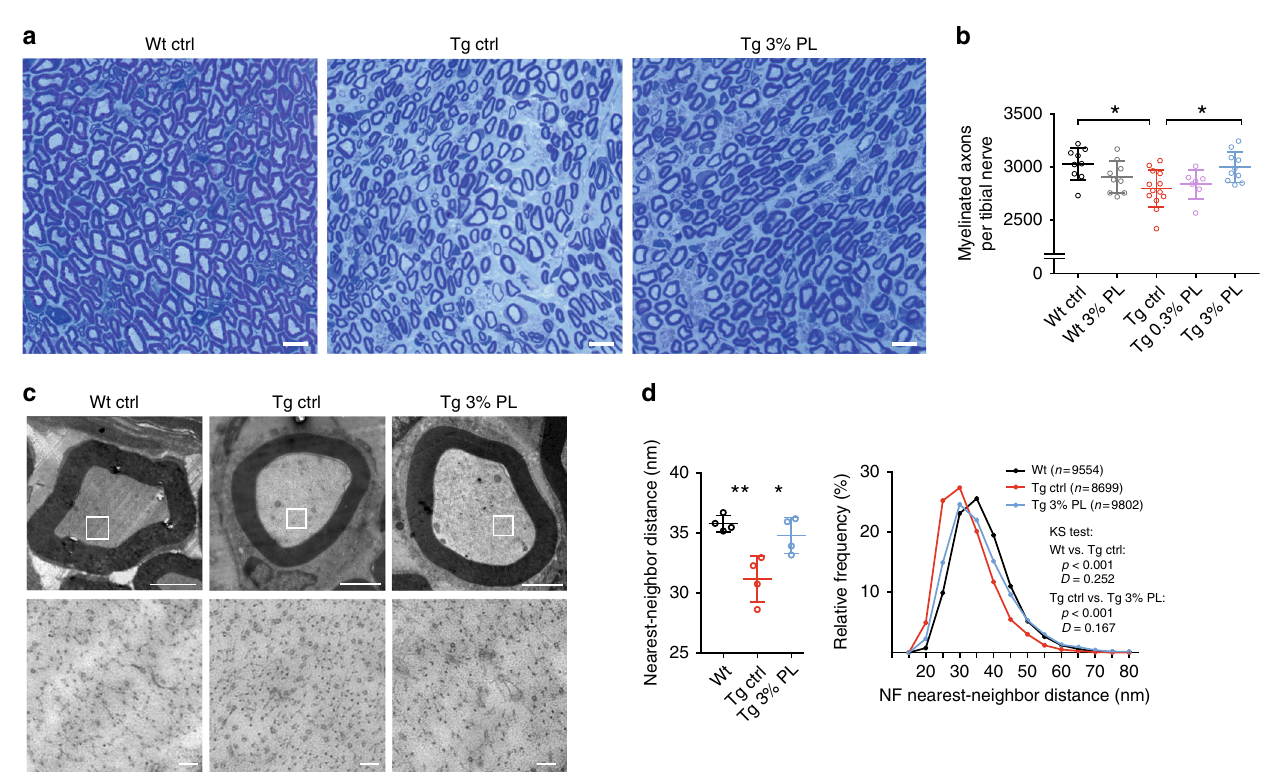
Fig. 3 Phospholipid therapy in CMT rats improves myelination. a Methylene blue semi-thin sections from tibial nerve cross sections at P112 from Wt ctrl (left), Tg ctrl (middle), and Tg 3% PL (right). Note the reduced density of myelinated fi beres in Tg ctrl compared with Wt ctrl, which is improved in Tg 3% PL (scale = 10 µ m). b Light microscopic quanti fi cation of a displays increased number of myelinated fi bers at P112 after 3% PL, but not 0.3% PL treatment (Wt ctrl, black, n = 9; Wt 3% PL, gray, n = 9; Tg ctrl, red, n = 13; Tg 0.3% PL, purple, n = 7; Tg 3% PL, blue, n = 10, one-way ANOVA, Tukey ’ s post test). c Representative electron micrographs showing neuro fi lament densities in axons wt, tg, and tg 3% PL. Whole myelinated fi bers (top row, scale 2 µ m) with blow-ups (bottom row, scale 100 nm) are shown. d Quanti fi cation of ( c ) with a nearest-neighbor analysis demonstrating a decreased neuro fi lament density in tg animals, which is improved upon PL treatment (left panel: n = 4 per group, 20 fi bers per animal, quanti fi cation of at least 200 neuro fi laments per fi ber, one-way ANOVA, Sidak ’ s post test, scale = 50 nm, standard deviation (SD), and standard error of mean (SEM); right panel: frequency distribution analyses of all measured neuro fi lament distances per group, Kolmogorov – Smirnov (KS) test, p value *<0.05 and **<0.01 and